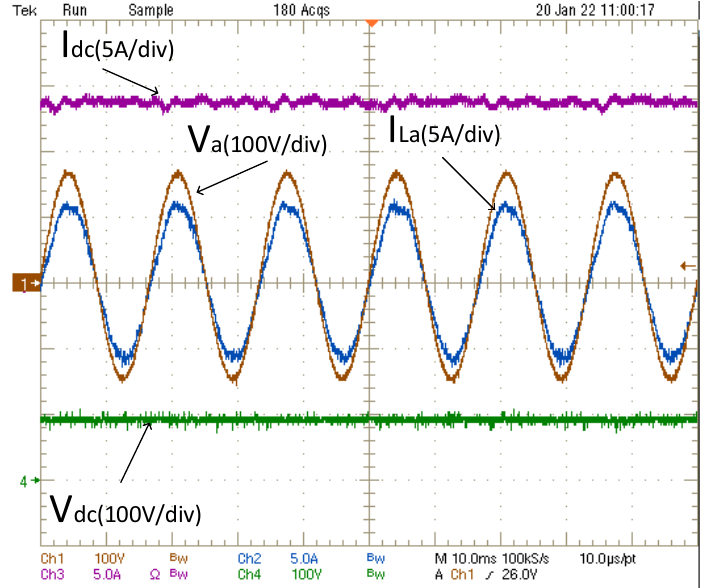
Figure 19. Experimental results in a steady state when the voltage at the terminals of each cell (50 cells in series) is set to 1.8 V. Test II (Table 2) with parameters in Tables 1 and 3.